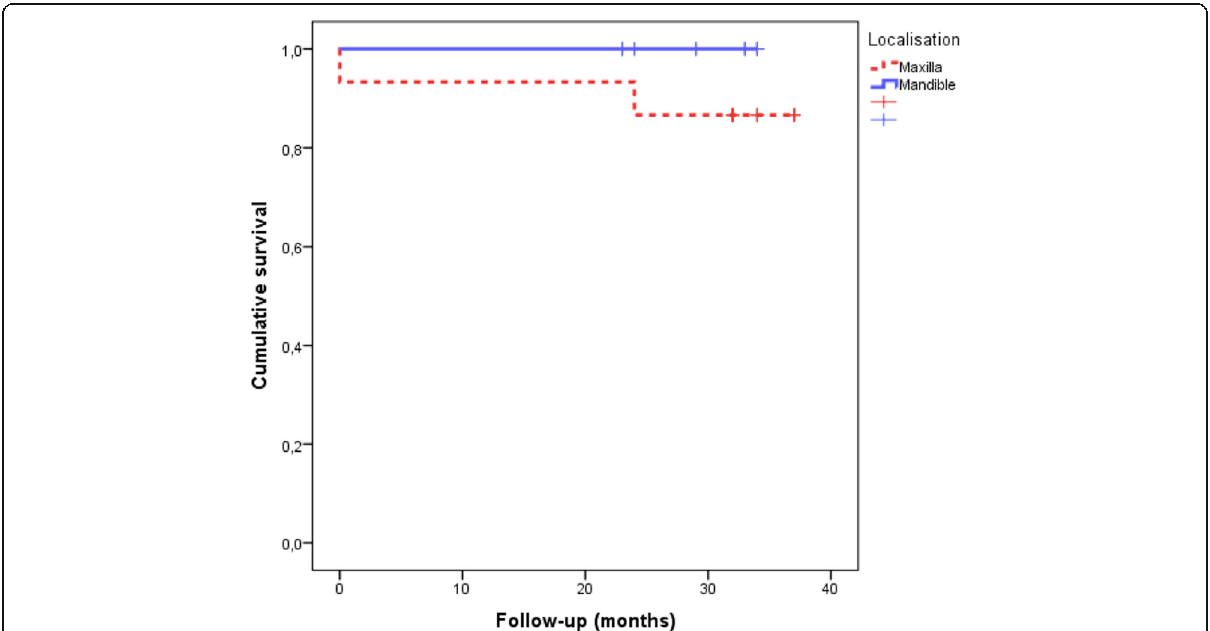
Fig. 2 Cumulative implant survival over the follow-up period. The Kaplan-Meyer diagram visualises the analysis of implant survival in the maxilla and in the mandible (log rank test, p = 0.173) over the follow-up period up to 37 months (Table 4)